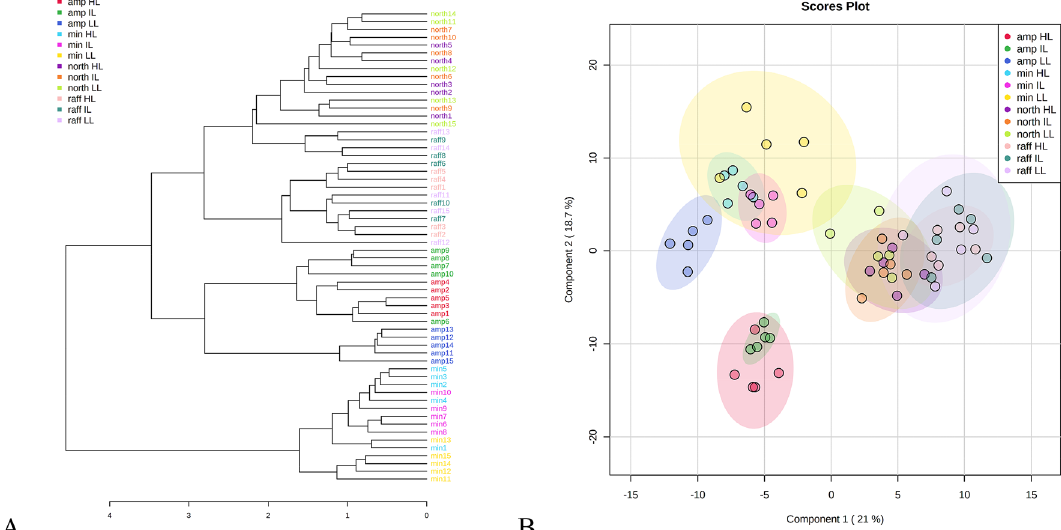
Figure 2. Metabolites profiles of the four Nepenthes species as influenced by the three different growing conditions. ( A ) Dendrogram showing the relationship among the samples using Pearson distances and average clustering. ( B ) Partial least squares–discriminant analysis (PLS-DA) score plot showing the spatial separation between the Nepenthes species and the provided growing conditions. Abbreviations: amp represents N . ampullaria , min represents N . minima , north represent N . northiana , and raff represents N . rafflesiana . The numbering after the species name represent the biological replicates. HL highland condition, IL intermediate condition, LL lowland